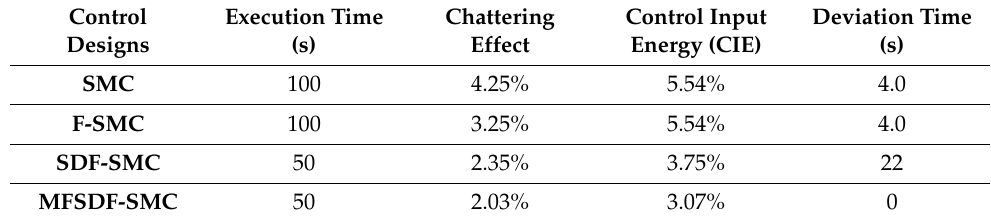
Table 4. Comparison between SMC, F-SMC, SDF-SMC and MFSDF-SMC algorithms.